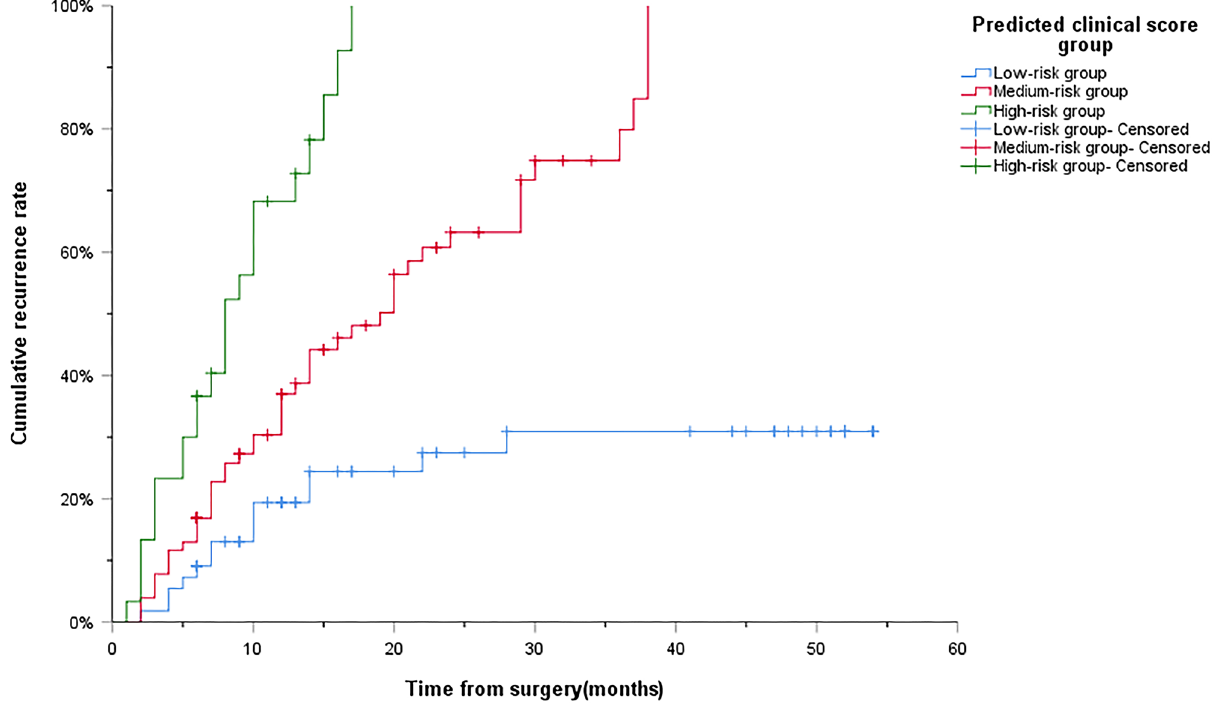
Figure 7. Preoperative clinical score grouping to predict the cumulative recurrence rate curve after RFA of HCC. Low-risk group: 0 to 1 score; Medium-risk group: 2 to 3 scores; High-risk group: 4 to 5 scores. RFA Radiofrequency ablation; HCC Hepatocellular